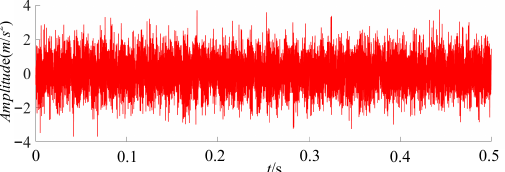
Figure 5. Time domain waveform of vibration signal of main pump in main pump normal